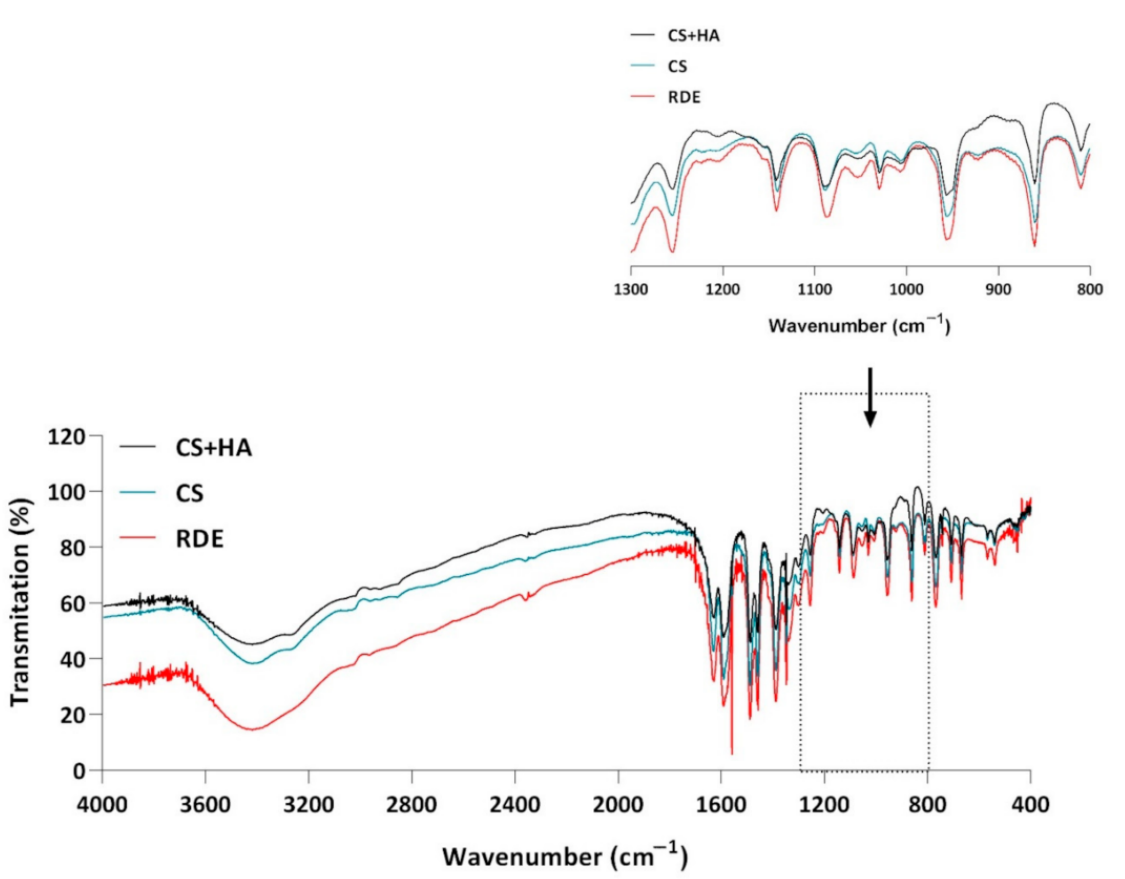
Figure 6. FTIR spectrum of choline salicylate (CS), a physical mixture of hyaluronic acid and choline salicylate (HA + CS), and residues after evaporation of eye drops with CS and HA (RDE) after 6 months of storage under accelerated test conditions (40 ◦ C/75%